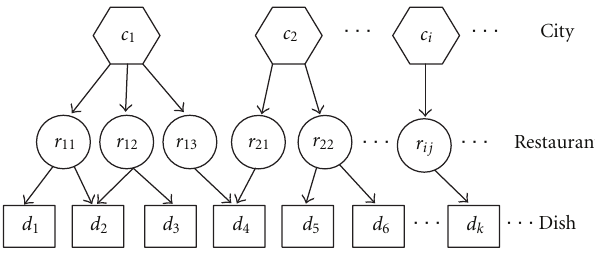
Figure 2: Hierarchical structure of local review data. Table 1: